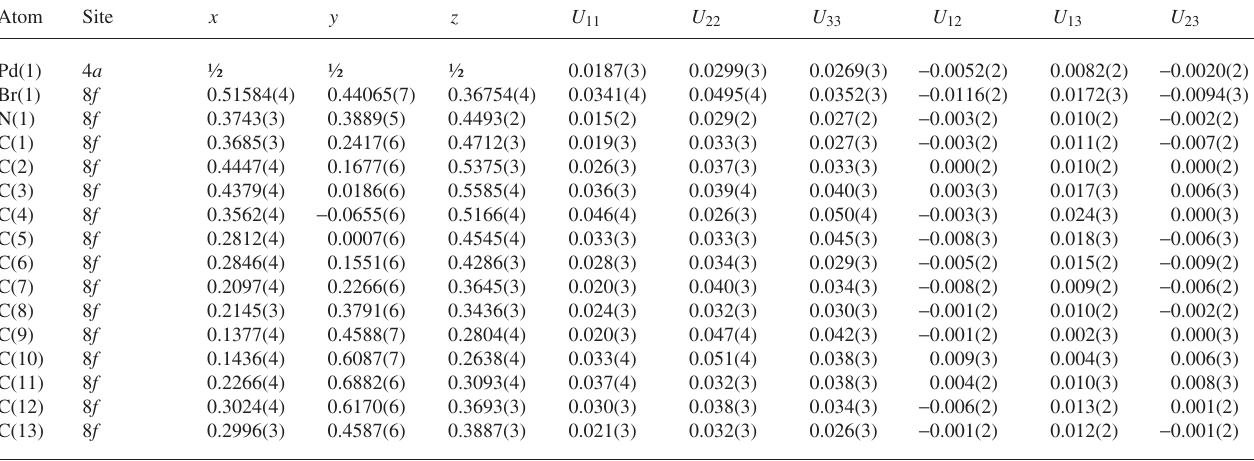
Table 3. Atomic coordinates and displacement parameters (in Å 2 ) .